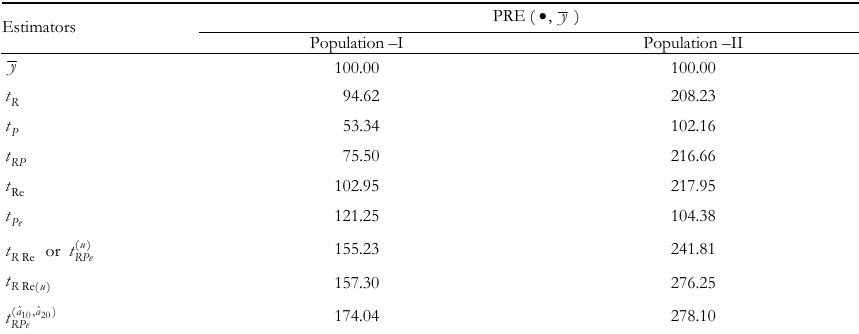
Table 7.1 exhibits that the proposed ratio-cum-product type exponential esti-